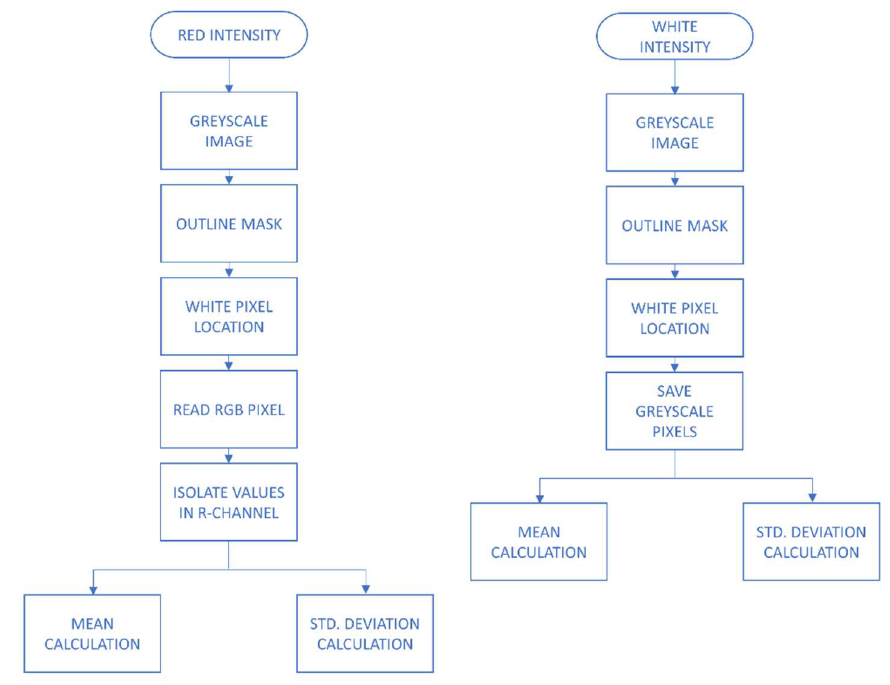
Figure 6. Routines for red and white intensity estimation.